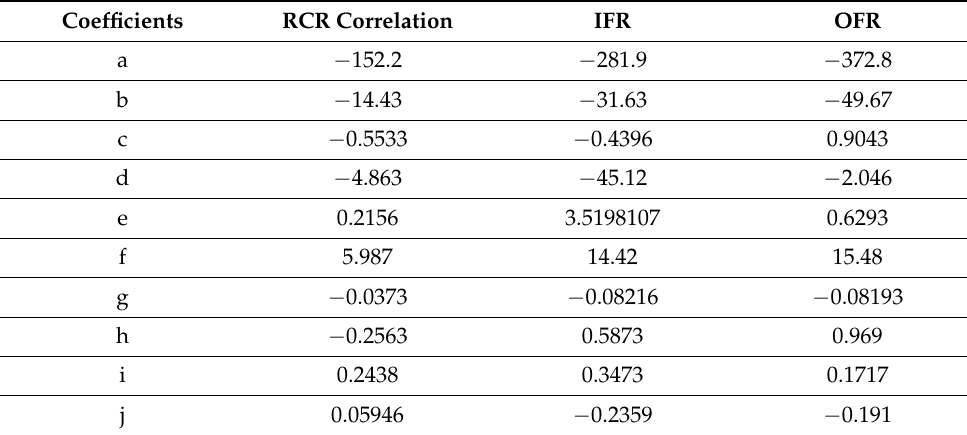
Table 4. Coefficients of simultaneous RCR, IFRF and OFRF FDD